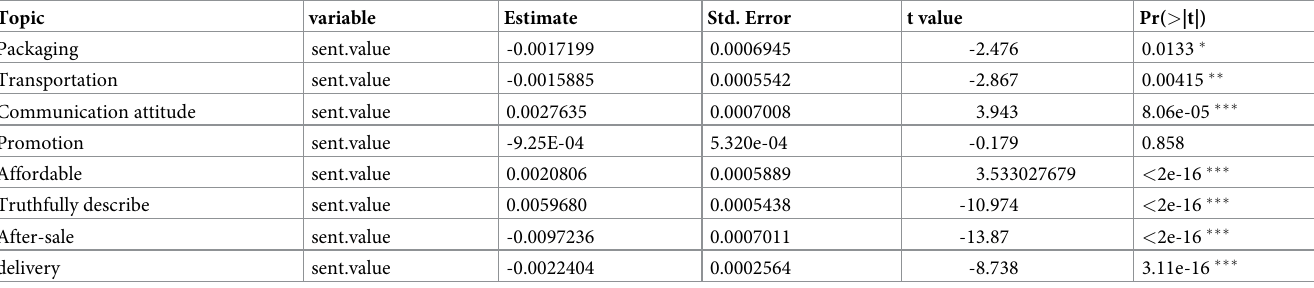
Table 2. Relationship between topic prevalence and sent.value under different